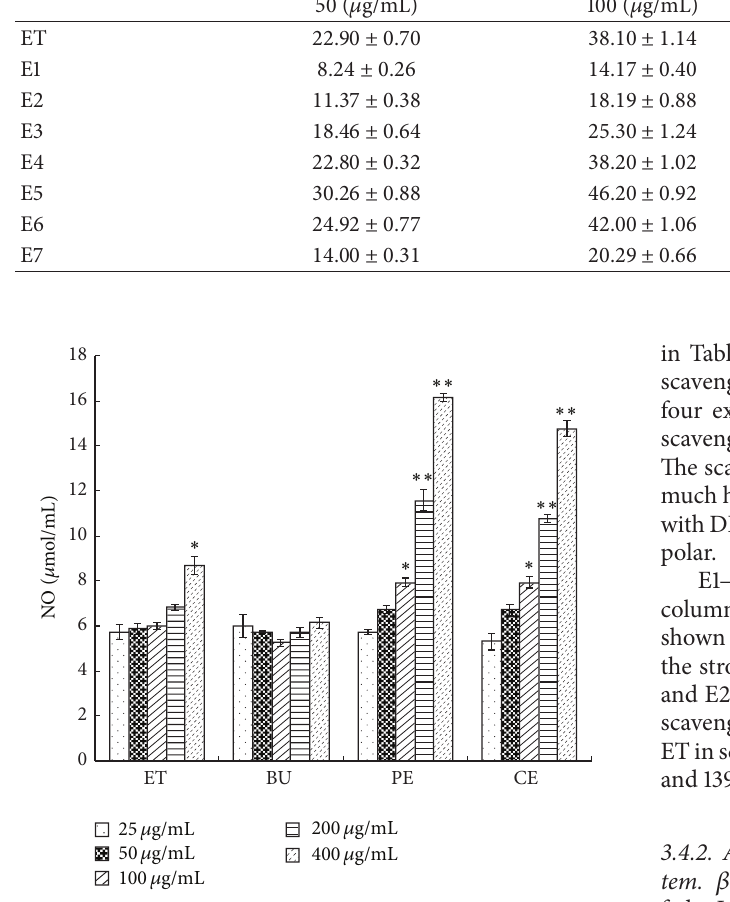
Figure 3: Effects of extracts on NO production. ∗ 𝑃 < 0.05 and ∗∗ 𝑃 < 0.01 compared with the